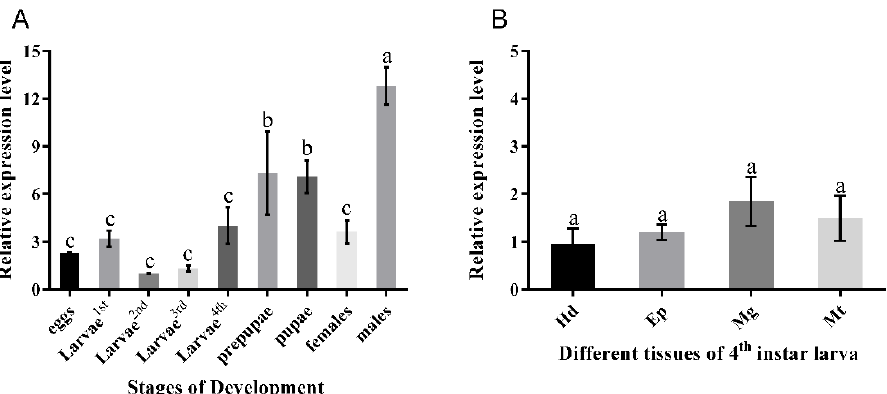
Figure 3. Relative level of expression (mean ± SE) of Oct β 3 in Plutella xylostella . ( A ) The levels of expression of PxOct β 3 genes in different development stages (first to fourth larvae, prepupae, pupae, adults, and eggs). The level of expression of PxOct β 3 in the second-instar larvae was used for comparison. ( B ) The levels of expression of PxOct β 3 in the tissues (head (Hd), epidermis (Ep), midgut (Mg), and Malpighian tubules (Mt)) of the fourth-instar larvae. PxOct β 3 in the Hd was used for comparison. The data were the mean values of three independent experiments (n = 3) and normalized to the endogenous ribosomal protein L32, which served as the internal control. Different letters above the bars indicate significant differences in different stages and tissues ( p < 0.05). Statistical comparisons were performed using one-way analysis of variance (ANOVA) followed by Tukey’s honest significant difference (HSD) test to determine whether significant differences occurred.